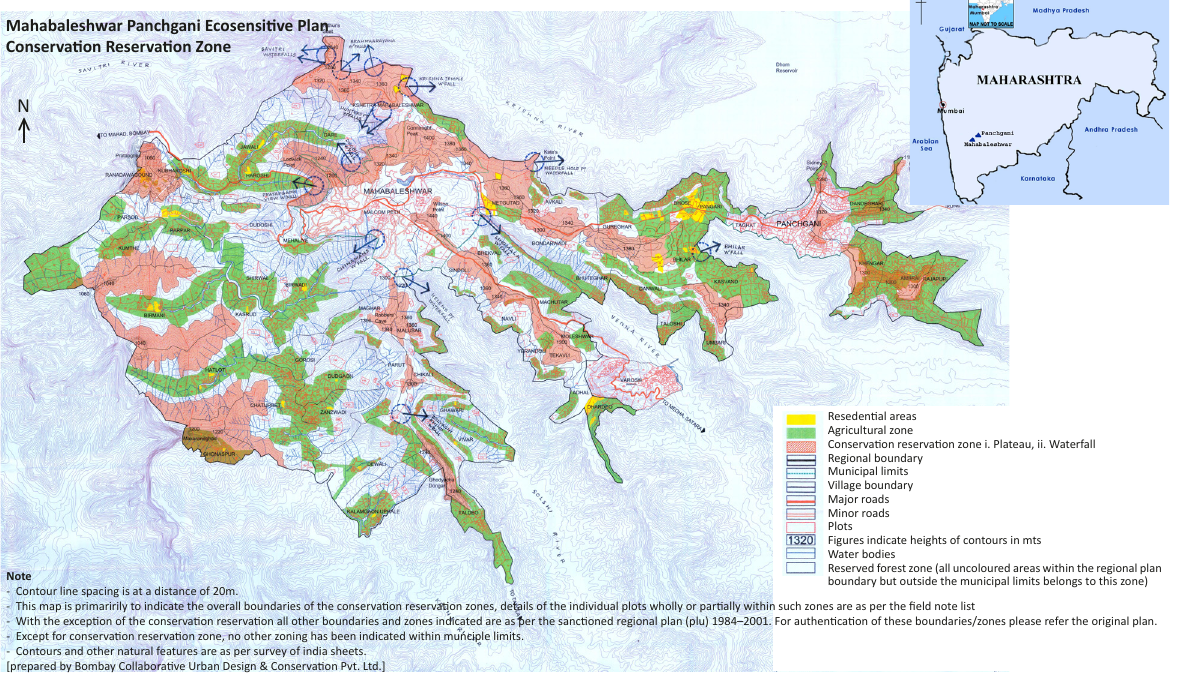
Figure 1. Study area. © The Bombay Environmental Action Group